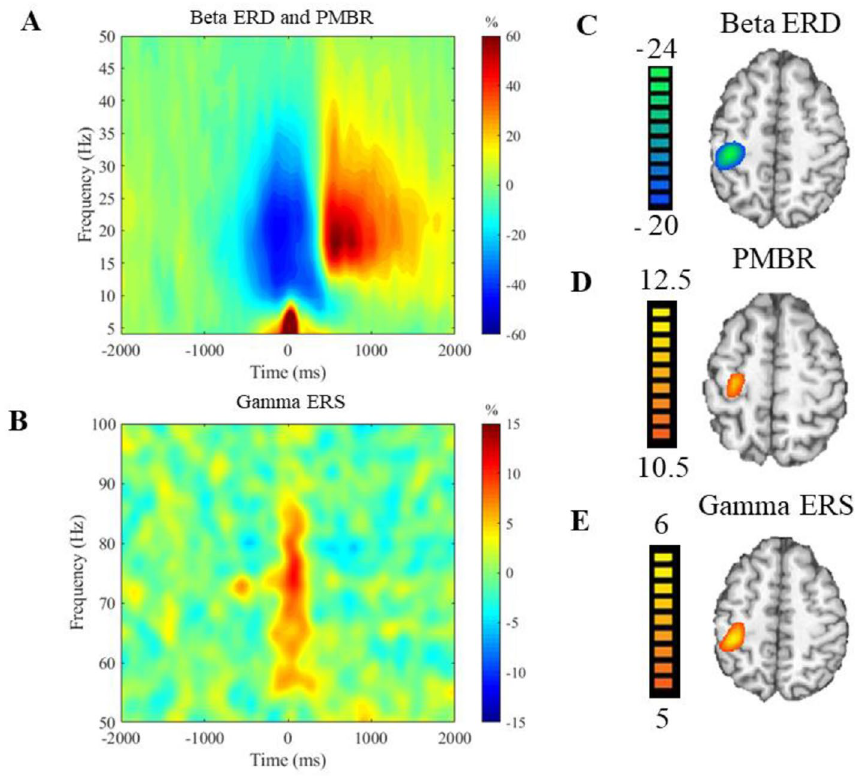
Figure 3. Sensorimotor spectrograms and group averaged beamformer images. ( A ) Averaged time–frequency spectrogram from a sensor located near the hand region of the contralateral (left) motor cortex averaged across all participants depicting the motor-related beta responses in the 0–50 Hz range. Time is denoted on the x-axis in milliseconds with 0.0 ms being movement onset, and frequency (Hz) is denoted on the y-axis. There was a beta ERD (18–26 Hz) that began about − 300 ms prior to movement onset and lasted until about 300 ms when the movement finished. After movement termination, there was a post-movement beta rebound (16–22 Hz) that lasted from about 500 to 800 ms before beginning to dissipate. ( B ) Averaged time–frequency spectrogram from a sensor located near the hand region of the contralateral (left) motor cortex depicting the 50–100 Hz range averaged across all participants. Beginning before movement onset around − 100 ms and lasting until about 100 ms after movement was a gamma ERS. Averaged beamformer images of the beta ERD ( C ) and the PMBR ( D ) depict that these responses were both located within the left sensorimotor cortices. ( E ) Group averaged image of the gamma ERS located in the contralateral (left) motor